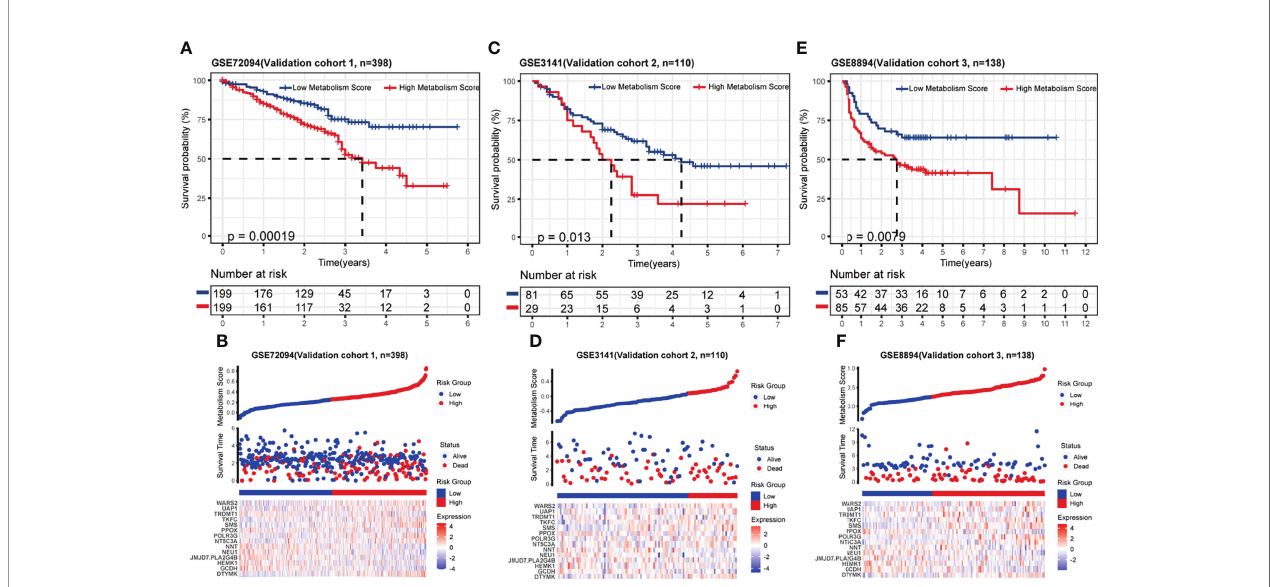
FIGURE 3 | Validation of metabolic-related prognostic model. (A-F) Survival status, risk and heatmap of NSCLC patients in low- and high- Metabolism Score subgroups based on 3 independent public datasets, three public datasets (GSE72094, lung adenocarcinoma, N=398; GSE3141, lung cancer, N=110; GSE8894, lung cancer, N=138).